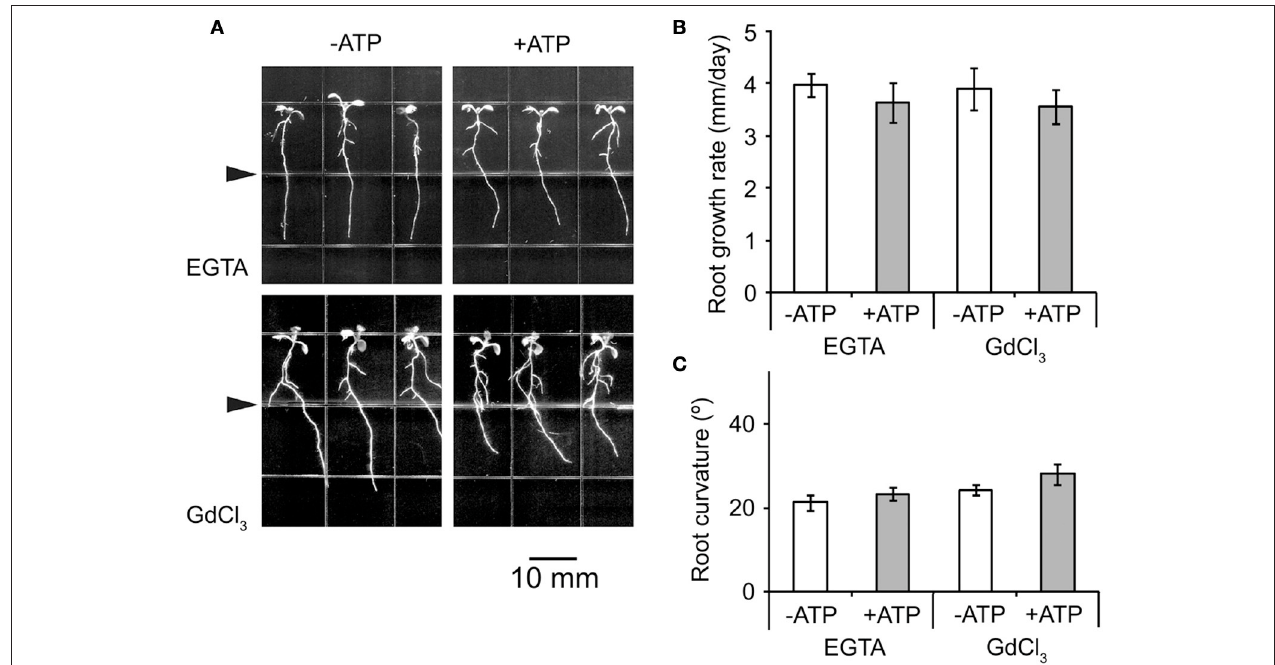
FIGURE 3 | Ca 2 + influx is necessary for eATP avoidance responses of Arabidopsis roots. (A) Seedlings of WS grown in jointed medium. EGTA (0.5 mM) or Gd 3 + (50 µ M) were added into 1/2 MS medium, then 0.3 mM ATP was added into the lower part of the jointed medium. The triangle marks the joint line of the two media. The scale bar is showed below. (B,C) note the root growth rate (B) and root curvature (C) before and after ATP treatments. Seedlings were photographed 5 days after transplantation. Primary root growth rate and curvature were measured in at least 30 seedlings, and data from 3 replicates were calculated to get the mean ± SD.